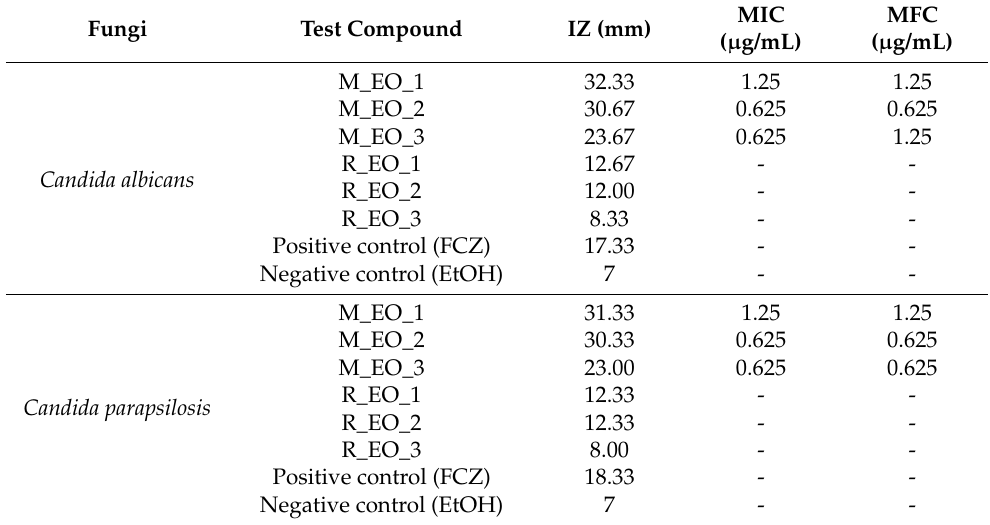
Table 5. The results of antifungal activity of M. piperita and R. officinalis essential oils.